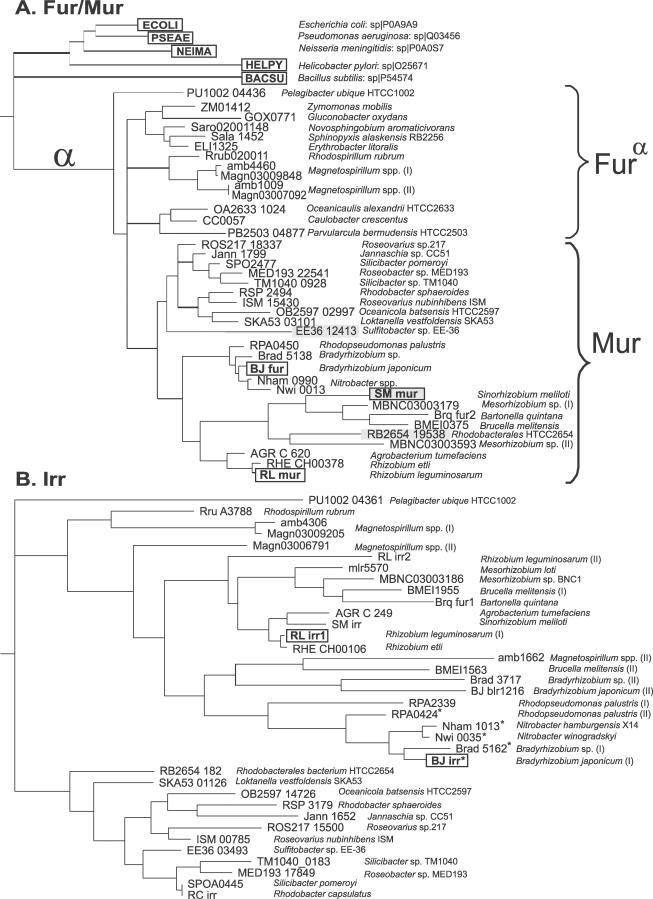
Phylogenetic Tree of α-Proteobacterial Regulators from the Fur Superfamily(A) Fur/Mur, (B) Irr. Experimentally characterized regulatory proteins are in bold and boxed. Positional clustering (i.e., close linkage) of the mur genes with the target manganese uptake sit operons is shown by background grey. Irr proteins with the heme regulatory motif (see text) at their N-termini are marked with asterisks. Functional annotation of the “mur” and “furα” regulators is based on the genomic analysis of their candidate regulatory motifs that occur in 5′ regions of either manganese or iron uptake genes, respectively. Possible role of the B. japonicum regulator Fur in the control of the manganese uptake gene mntH was predicted in this study and is not yet proved.